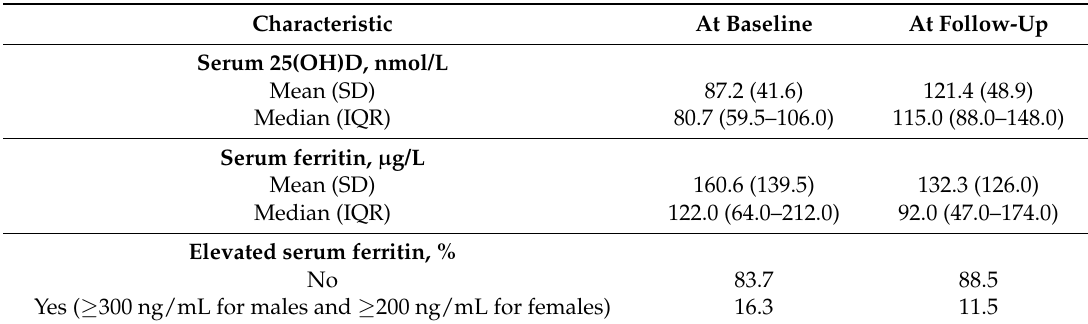
Table 1. Serum 25(OH)D and serum ferritin levels at baseline and at the follow-up of 6812 study